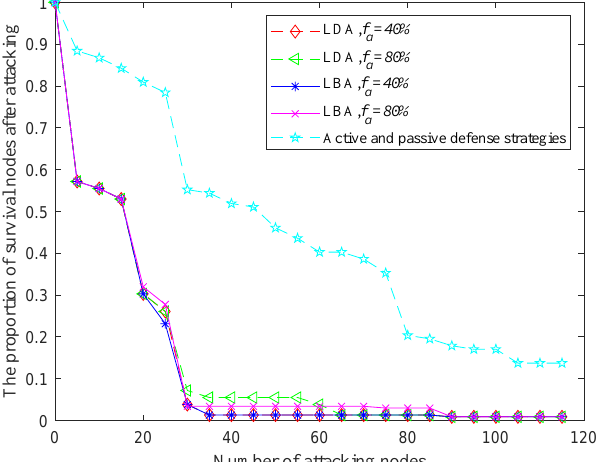
Figure 9. Comparision active and passive defense strategies with traditional method.